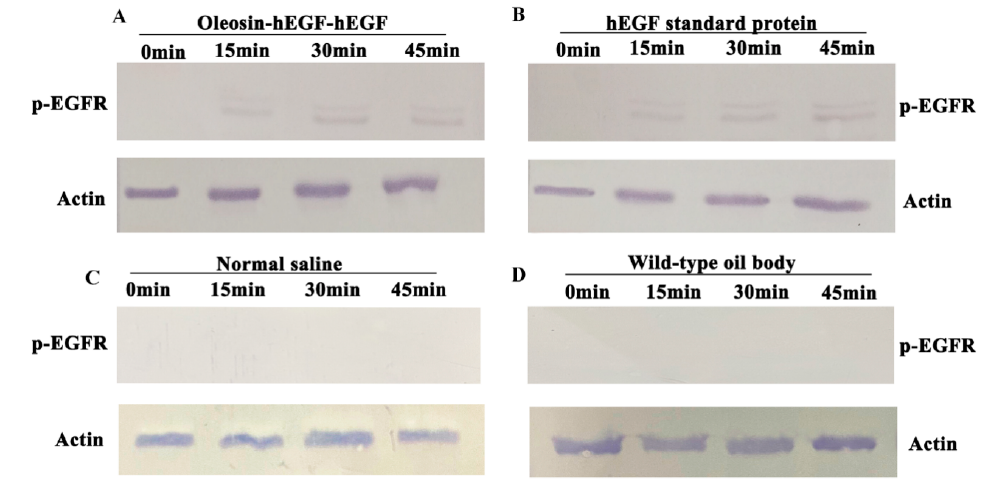
Figure 6. Analysis of activation of p -EGFR. Activation of p -EGFR after ( A ) oleosin–hEGF–hEGF; ( B ) hEGF standard protein; ( C ) normal saline and ( D ) WT oil body treatments 1–3.